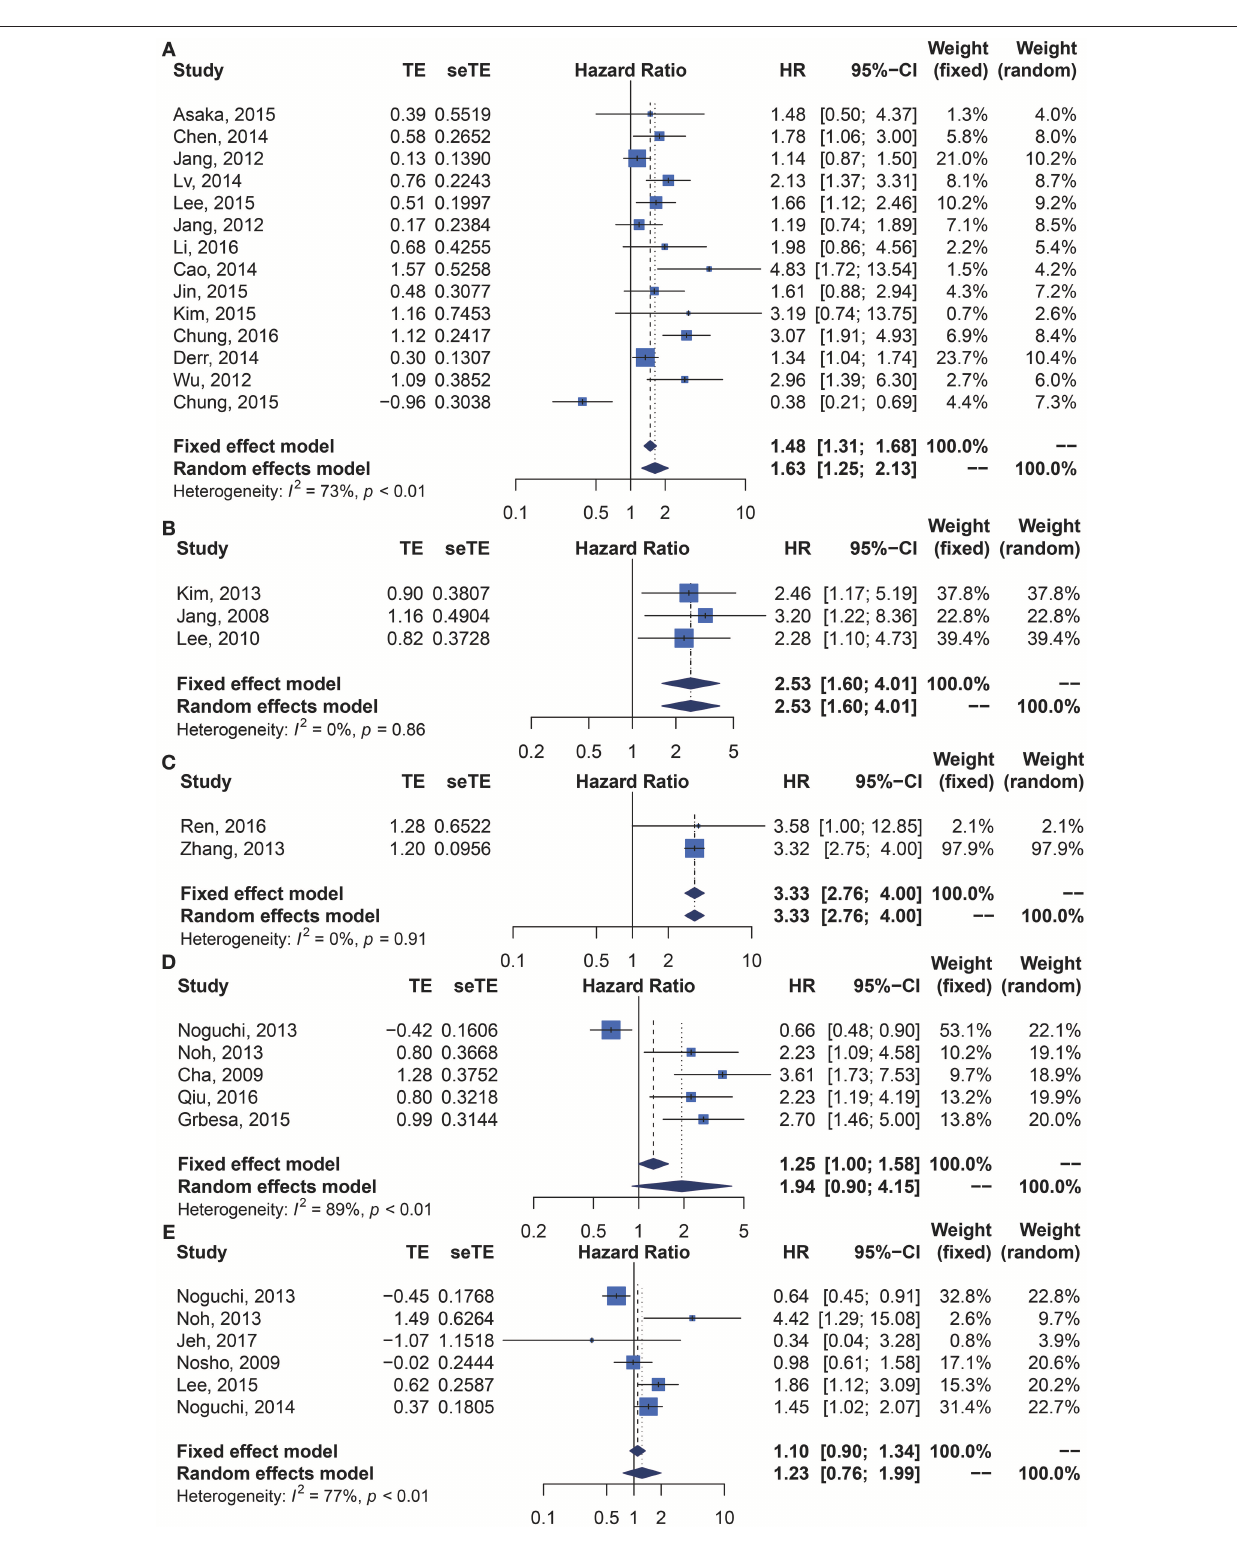
FIGURE 3 | Forest plots of main survival outcomes compared SIRT1 overexpression with underexpression. (A) DFS. (B) EFS. (C) PFS. (D) RFS. (E) CCS.